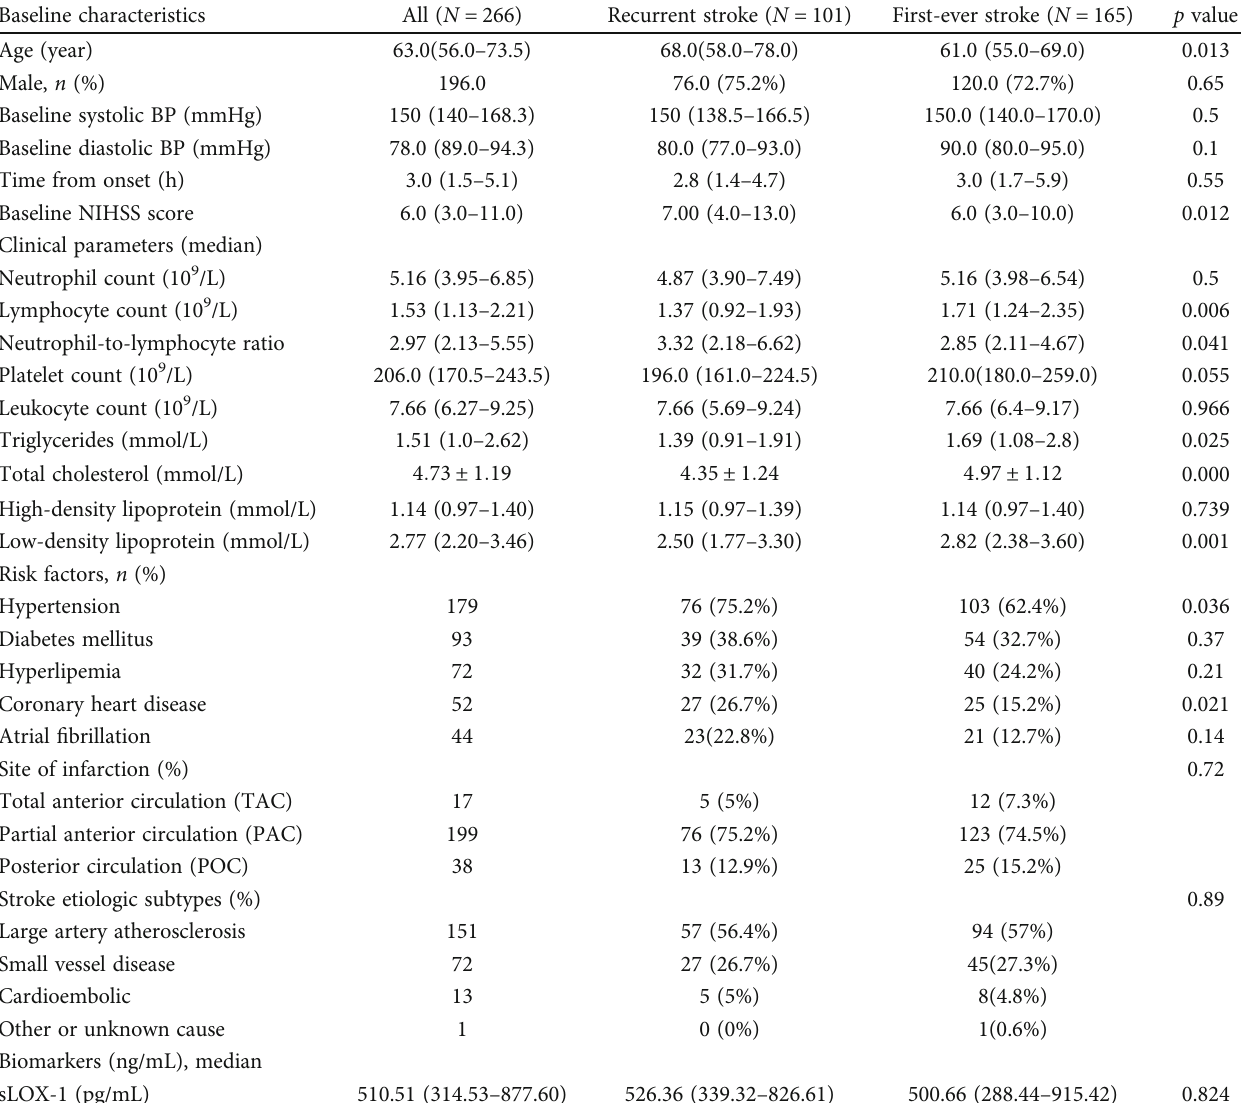
Table 1: Baseline characteristics in patients with fi rst-ever and recurrent